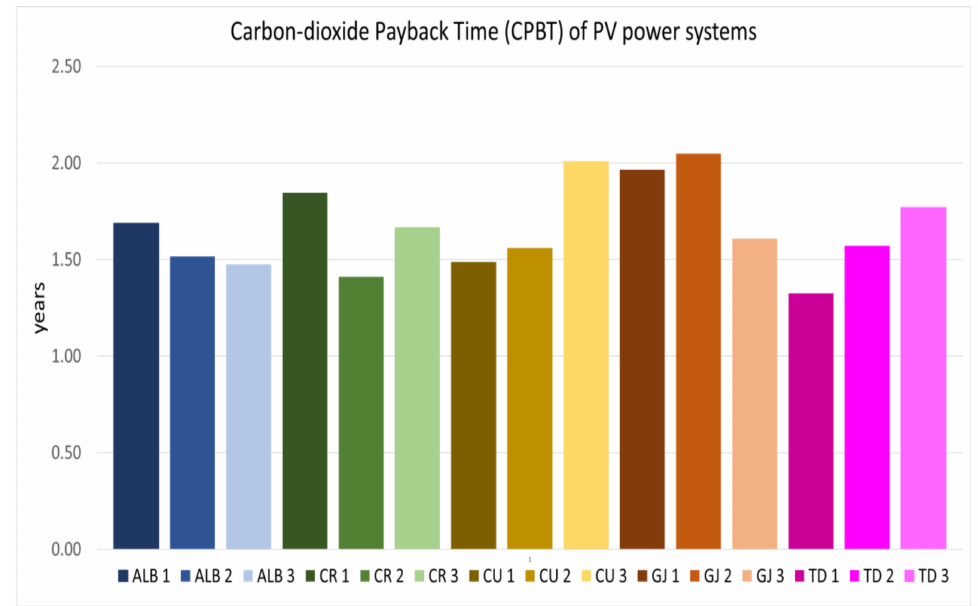
Figure 7. Carbon-dioxide Payback Time for the different PV power centrals in Castilla—La